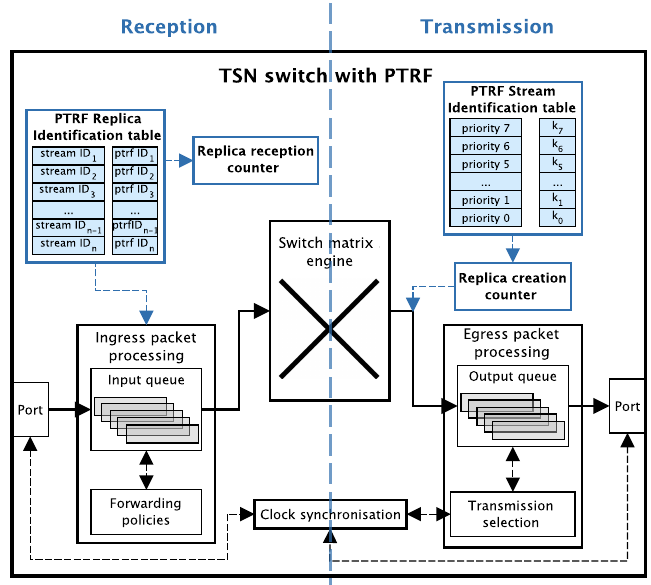
Figure 4. Basic architecture of a TSN bridge with the PTRF mechanism. The additional components PTRF includes are highlighted in blue. Solid lines represent the path frames follow inside the bridge, whereas discontinuous lines represent management or configuration interactions. Reproduced as in